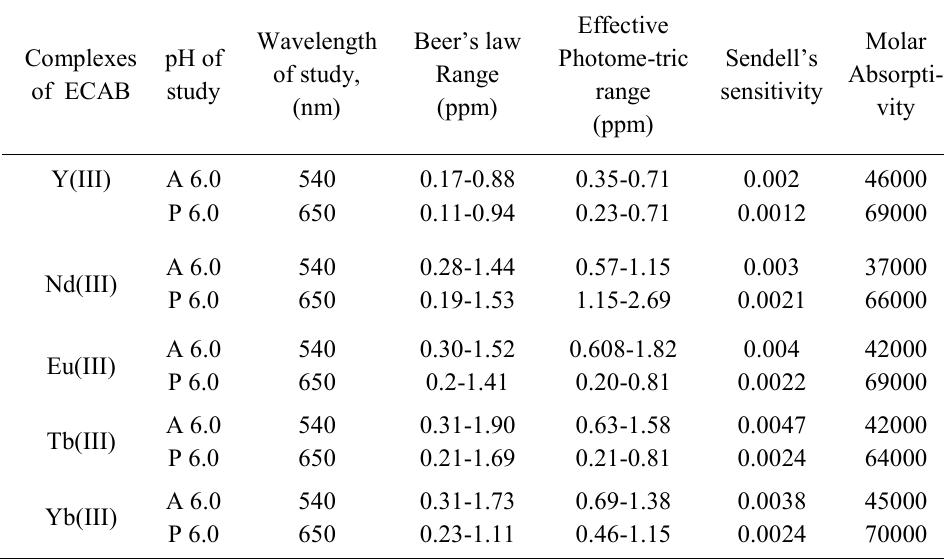
Table 5. Photometric determination of lanthanides with ECAB in absence and presence of